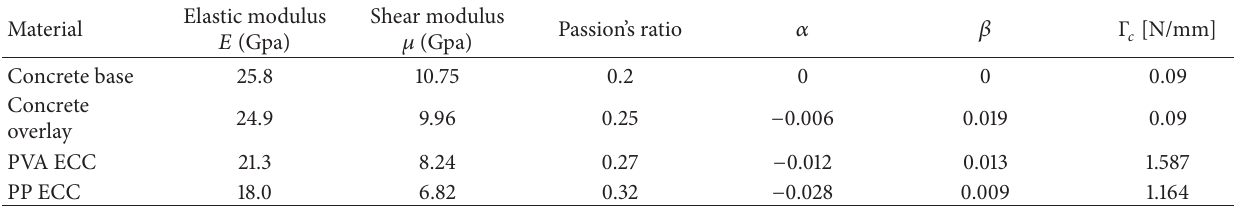
Table 1: Property of concrete base and repair